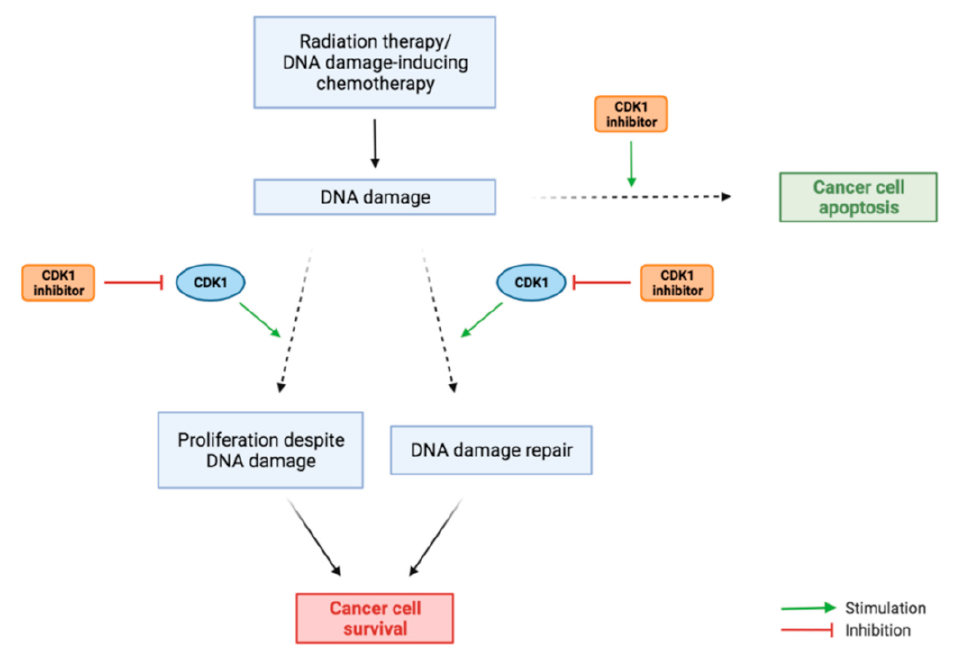
Figure 6. Interaction of CDK1 inhibitors in combination with radiation treatment and chemotherapy. CDK1 overactivity stimulates DNA damage repair and the proliferation of cells despite DNA damage (via cell cycle checkpoint evasion), leading to survival of cancer cells. CDK1 inhibitors combat this effect, stimulating the pathway from DNA damage which leads to